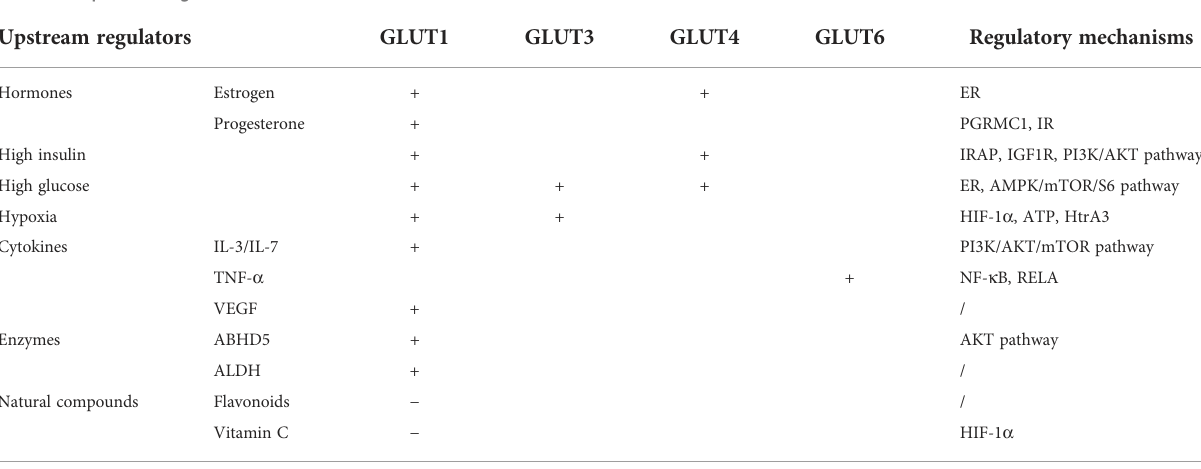
TABLE 2 Upstream regulators of GLUTs in endometrial